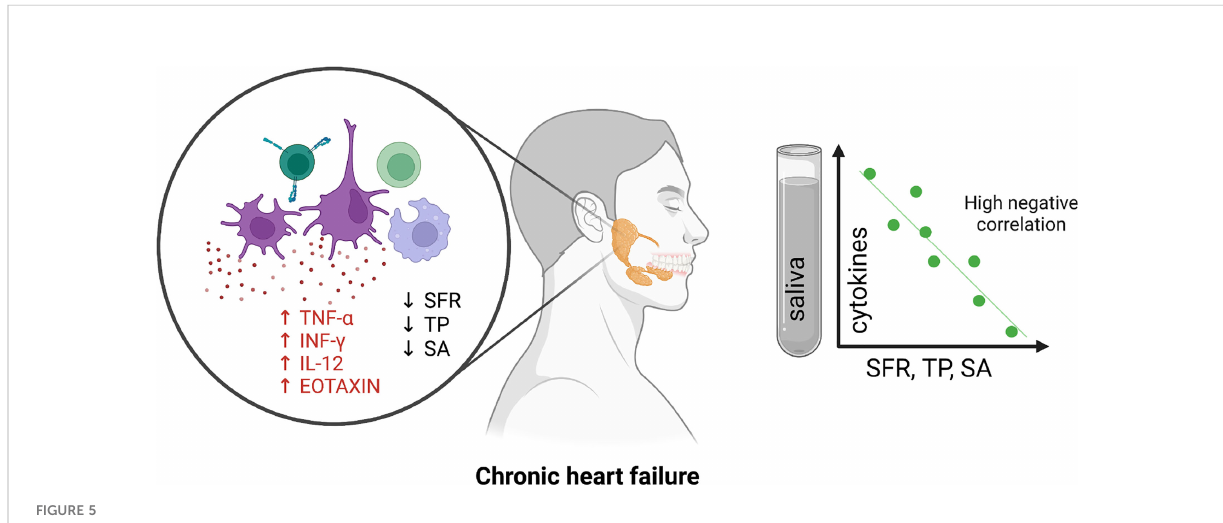
FIGURE 5 Graphical conclusions from the